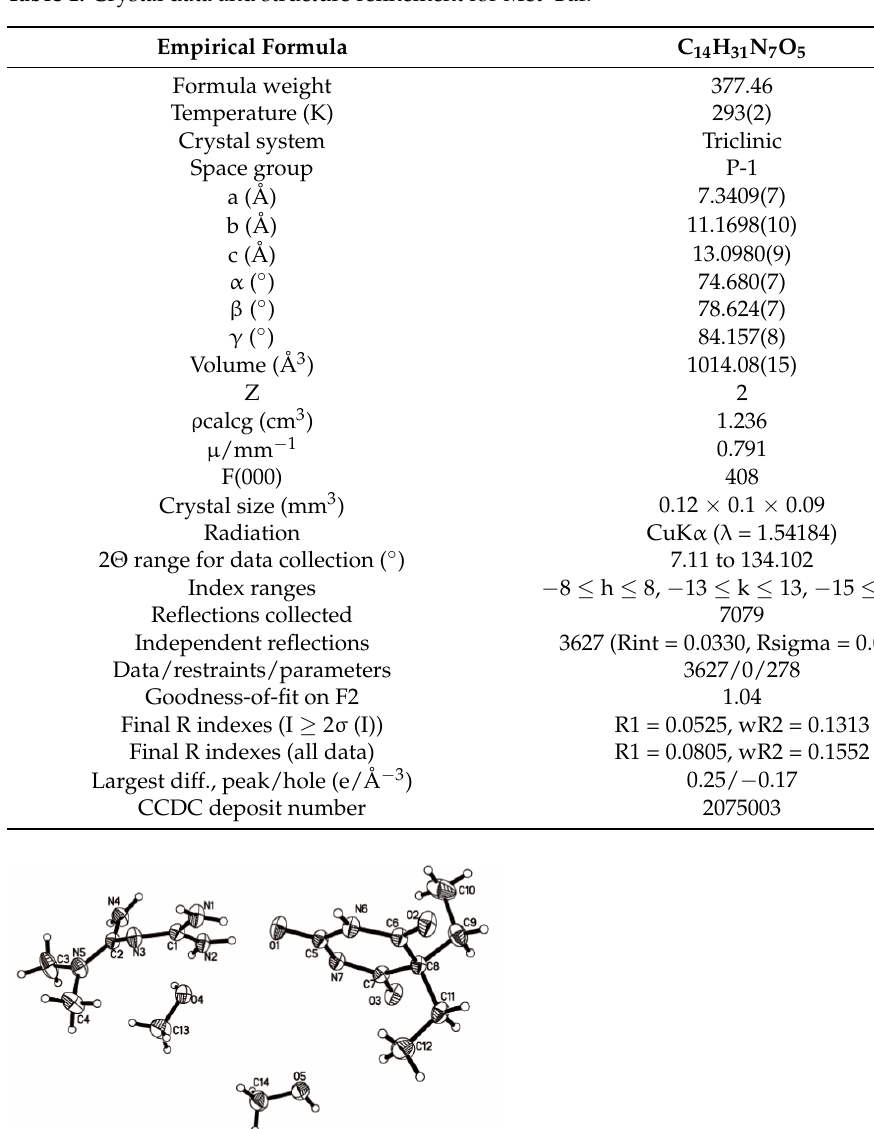
Table 1. Crystal data and structure refinement for Met–Bar.